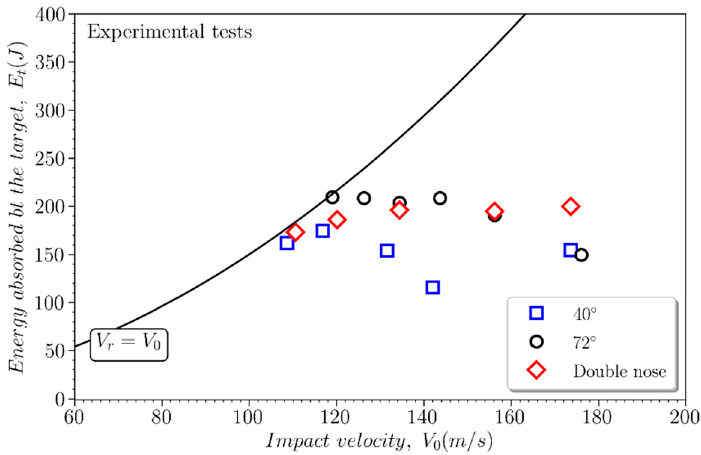
Figure 5. Energy absorbed by the specimen E a versus impact velocity V 0 .